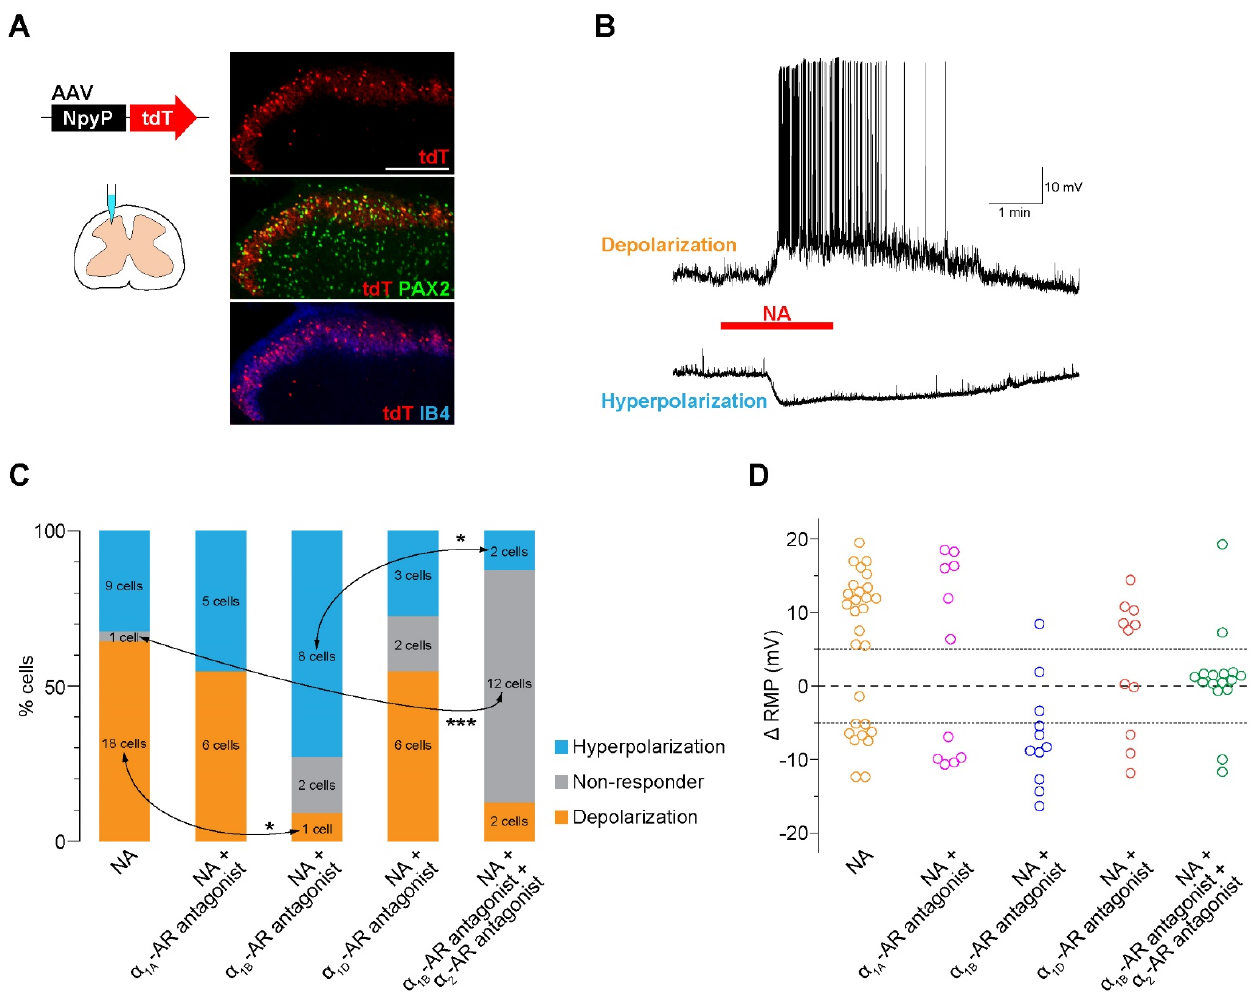
Figure 1. NA excites the majority of AAV − NpyP + neurons via α 1B − AR. ( A ) tdTomato (tdT) expression on the fourth lumbar (L4) spinal dorsal horn (SDH) 4 weeks after microinjection of AAV − NpyP − tdT. Scale bar, 200 µ m. Immunolabeling of tdT + cells (red) with the inhibitory interneuron marker PAX2 (green) or the lamina IIi − selective marker IB4 (blue). ( B ) Representative electrophysiological traces of AAV − NpyP + neurons that were depolarized and hyperpolarized by NA application (20 µ M for 2 min). ( C ) Percentage of AAV − NpyP + neurons which responded to NA or NA with each antagonist selective for AR subtypes ( n = 28 cells from 15 rats for NA, 11 cells from 3 rats for NA + silodosin ( α 1A − AR antagonist), 11 cells from 4 rats for NA + L − 765,314 ( α 1B − AR antagonist), 11 cells from 3 rats for NA + A − 315456 ( α 1D − AR antagonist), and 16 cells from 6 rats for NA + L − 765,314 ( α 1B − AR antagonist) + atipamezole ( α 2 − AR antagonist). * p < 0.05, *** p < 0.001, Fisher’s exact test followed by Bonferroni adjustment. ( D ) Change in resting membrane potentials ( ∆ RMPs) of AAV − NpyP + neurons before and after NA in slices with or without each AR subtype − selective antagonist